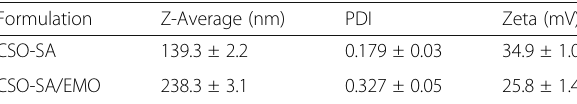
Table 1 Physicochemical properties of CSO-SA and CSO-SA/